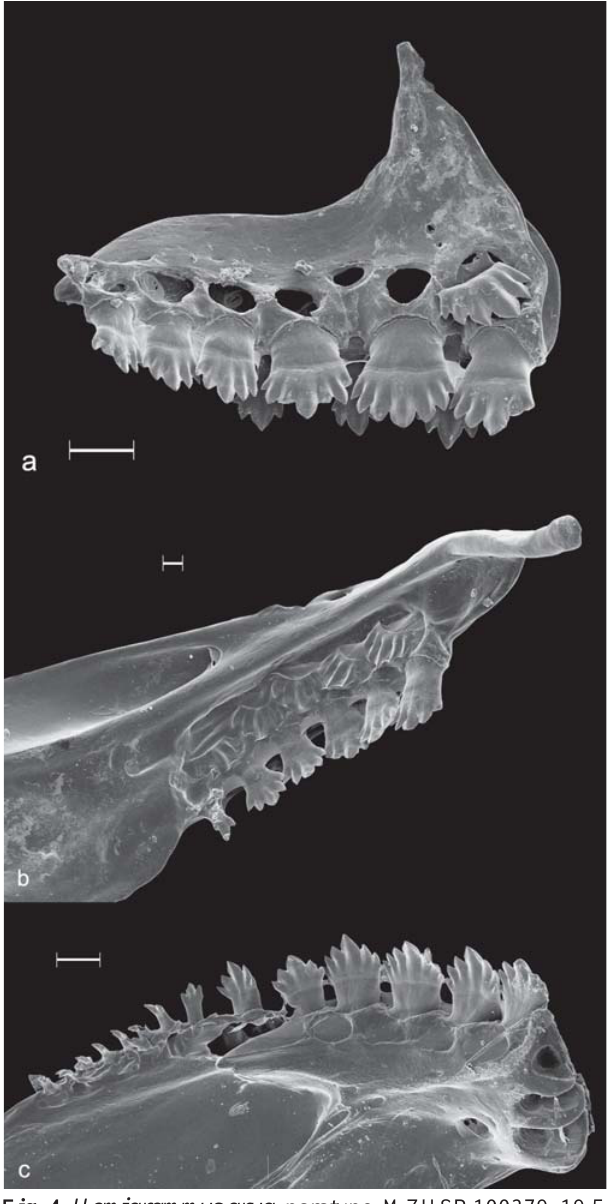
Fig. 4. Hemigrammus arua , paratype, MZUSP 100379, 19.5 mm SL; scanning electron micrographs (SEM) showing left premaxillary (a), maxillary (b), and dentary teeth (c) in mesial view. Scale bar: (a-c): 100 µ m; (b) 30 µ